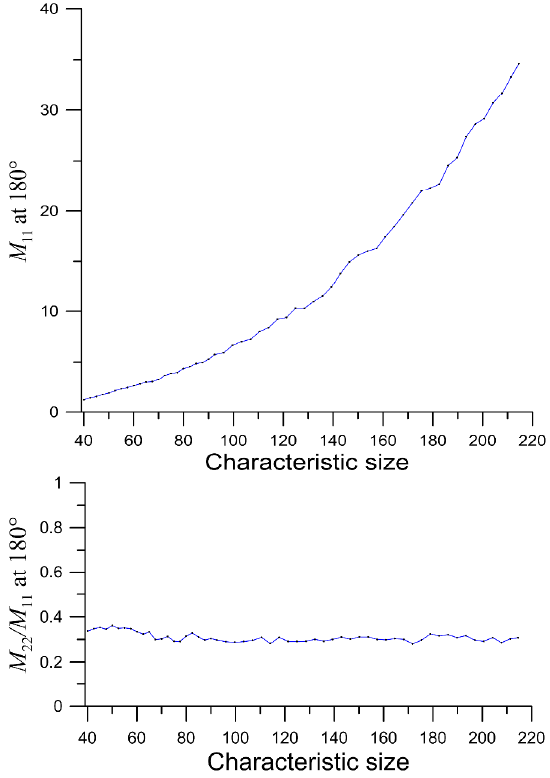
Figure 8. The elements of the Mueller matrix at exact backscattering